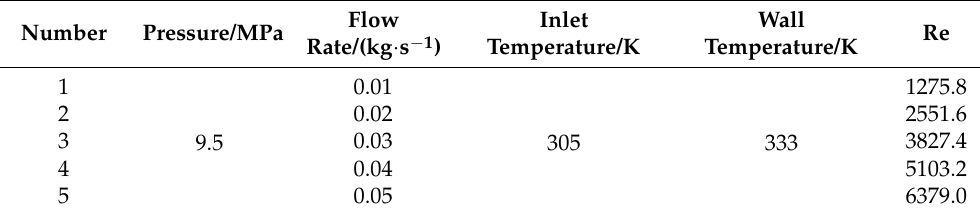
Table 1. Simulation working